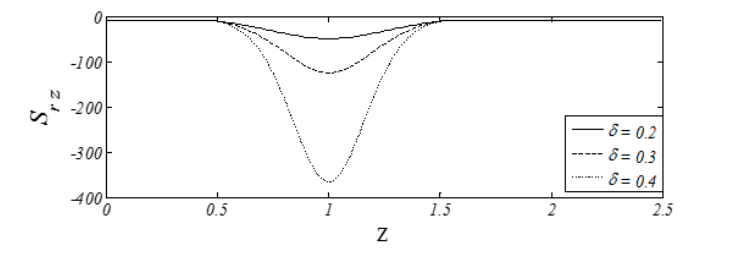
Fig. 8 Wall shear stress variation for F=1, L=1, a=0.2, b=0.4, m=1.